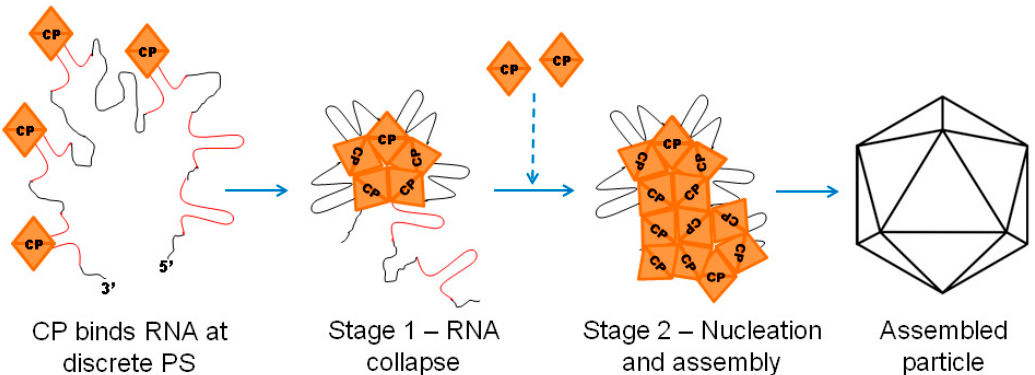
Figure 3. Model of the two stage assembly mechanism: The model is based off of evidence that multiple discrete PS exist on the genomes of viruses such as MS2, STNV, and HBV. These PS (highlighted in red) serve as binding sites for the CP of the virus. Stage 1 refers to the collapse of the RNA into a condensed form following inter-CP interactions. Stage 2 is represented by nucleation of the CPs on the RNA and the addition of further CP molecules (dotted arrow), which result in assembly of the particle. In this manner, multiple PS, dispersed on the genome, define the incorporation of the CP and the eventual assembly of the particle. Adapted from Borodavka et al., 2012 [89].